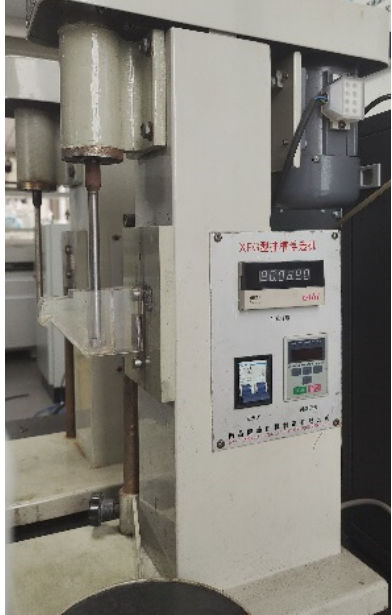
Figure 2. The XFG flotation machine used in the study.